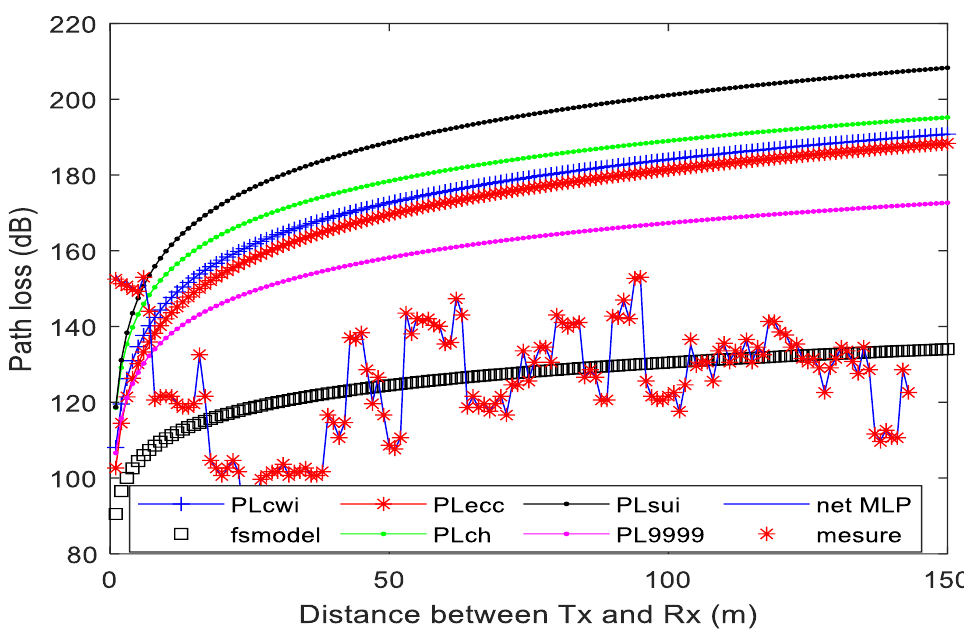
Figure 16. Comparison between empirical models and MLP (with two hidden layers) for Dataset 8.